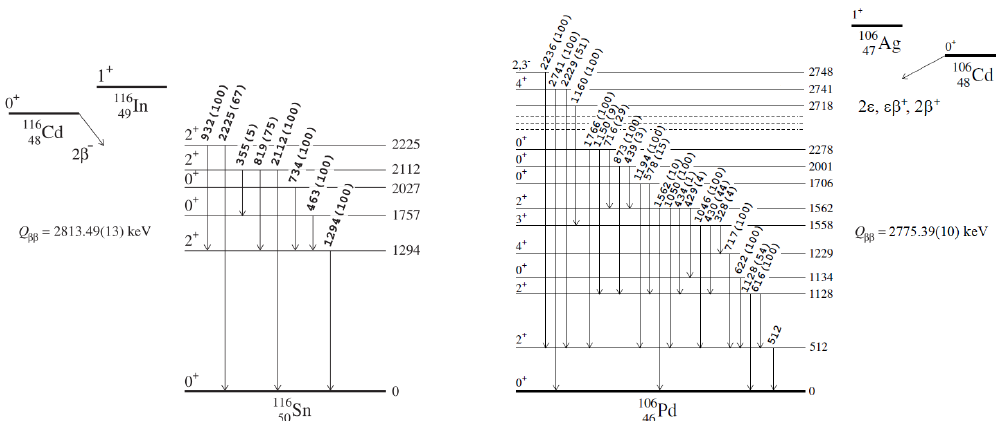
Figure 17. Simplified decay schemes of 116 Cd ( left ) and of 106 Cd ( right ). The energies of the excited levels and the emitted γ quanta are in keV; the relative intensities of γ quanta are given in parentheses. Their values are taken from References [68,84].